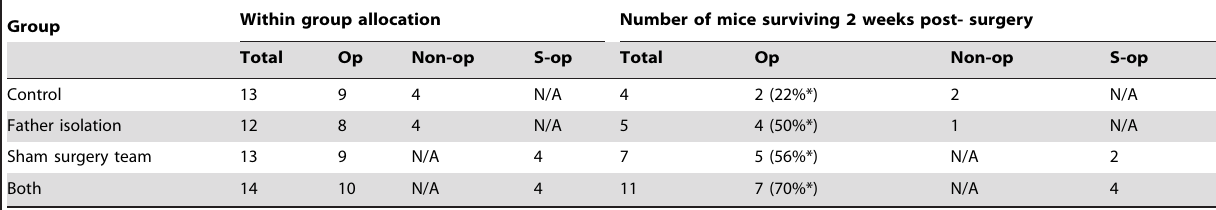
Table 1. Survival after surgery by experimental group.